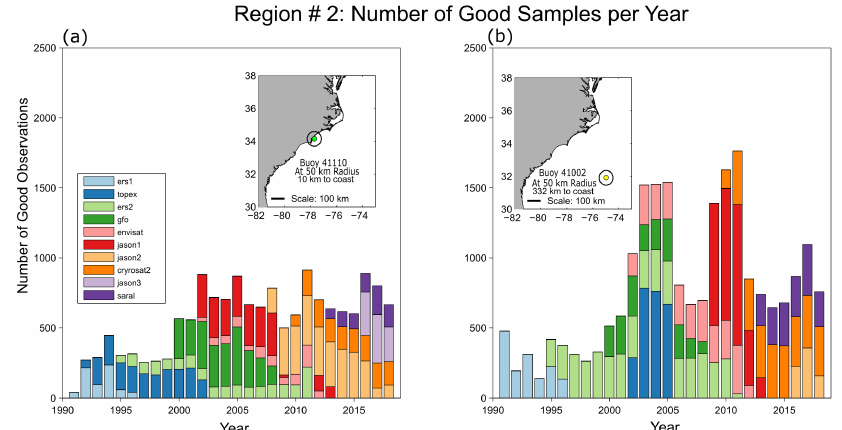
Figure 6. Total number of good (qual_flag = 3) Hs observations per year in region #2, ( a ) at nearshore buoy 41110 and ( b ) offshore buoy 41002 based upon a 50 km sampling radius around each